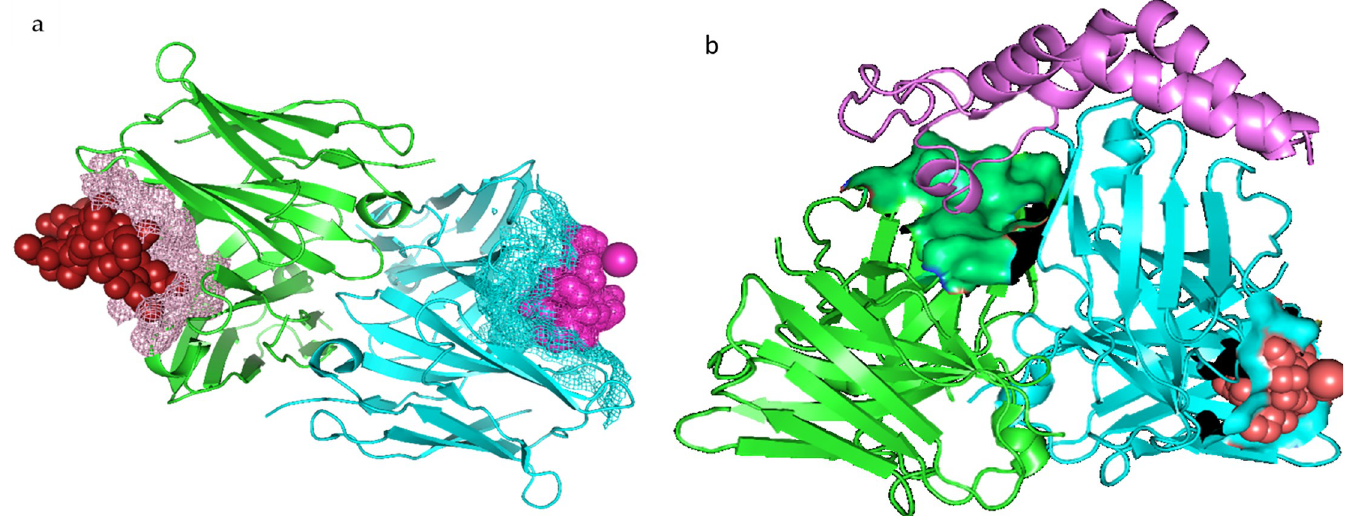
Fig 7. Docking morph originating from the interaction of the HBsAg and snail mucus protein with the human immunoglobulin against HBV (PDB_ID– 5YAX) and comparison with the result when standalone HBsAg is docked to 5YAX. a). The best prediction (-2646.06) for docking Morph to 5YAX. The brick red sphere represents the morph while the purple mesh are the surrounding interacting atoms on the variable region on the Fab segment of the heavy chain. The purple sphere represents the Pres1 peptide interacting with similar variable region of the light chain (blue mesh) of the Fab fragment. b). The best prediction when the standalone HBsAg envelope protein (the purple Helix-Turn-Helix Structure) is docked 5YAX. The green surface are residues of 5YAX interacting with the HBsAg which are not exactly the variable region of the heavy chain where antigen can bind. The red sphere is the Pres1 peptide interacting with residues on the light chain of 5YAX (blue